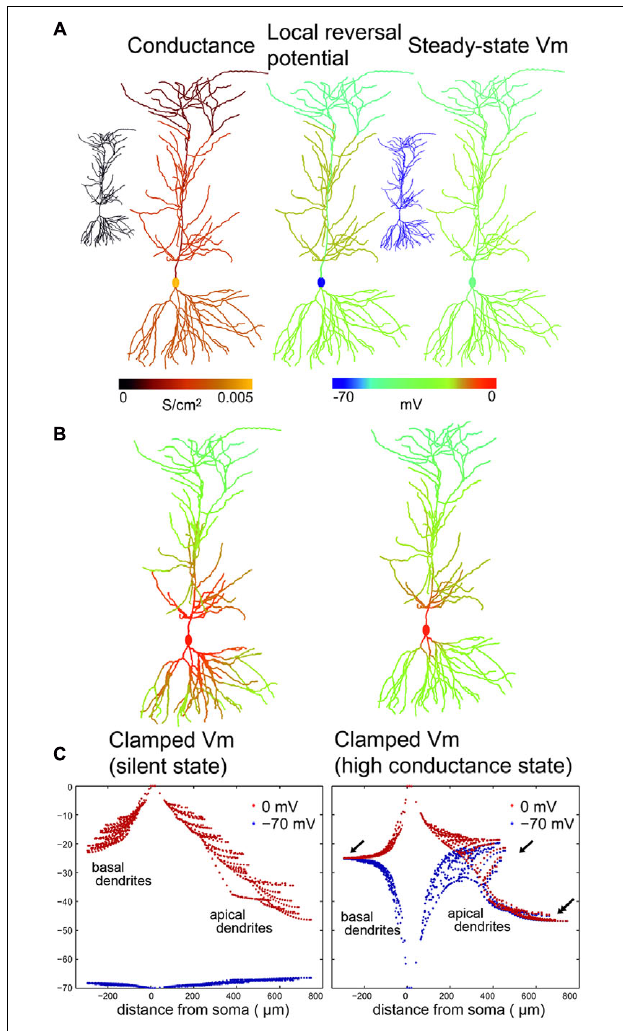
FIGURE 4 | Calculated voltage clamp (VC) errors in silent and high conductance states in a CA1 PC with passive membrane properties. (A) Left: Conductance distribution (synaptic plus leak) over a simulated PC in high-conductance state (HCS), which results from activation of excitatory and inhibitory synapses with the measured distribution at a realistic rate. Center: Spatial distribution of the local reversal potential for the net membrane current. Right: The resulting location-dependent equilibrium potential from a simulation of the cell with local conductances and reversal potentials given by the previous two panels. The two small insets on the left and right show that, in the silent state (SS), all of these values are homogeneous over the cell (and both the local reversal potential and the equilibrium potential equal the global resting potential everywhere). (B,C) Membrane potential distribution over PC compartments in the presence of somatic VC in the SS (left) and in the HCS (right) are presented in two alternative ways. (B) is a color representation, while (C) shows the distribution of membrane potential as a function of distance from the soma. While (B) shows the potentials when the soma was clamped to 0 mV, (C) shows the distribution for two clamp potentials: − 70 mV (blue) and to 0 mV (red). Note that the space clamp error quickly increases and has much higher absolute values when the soma is clamped to 0 mV, due to the larger difference between the local resting membrane potential and the clamping target potential. In the HCS the basal and apical dendrites are pulled toward approximately − 25 mV (arrows) while the apical dendritic tuft is pulled toward − 45 mV (double arrow) due to the higher ratio of inhibitory inputs in these distal